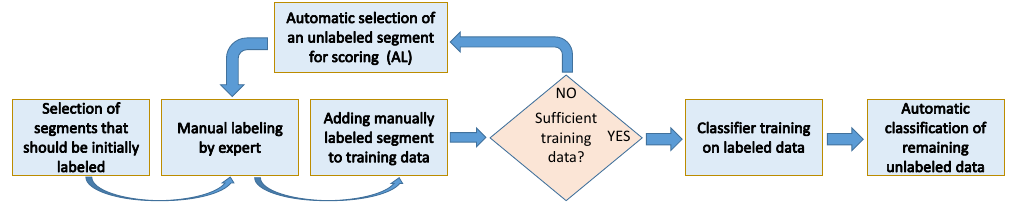
Figure 2. The flow diagram of semi-automated scoring of EEG